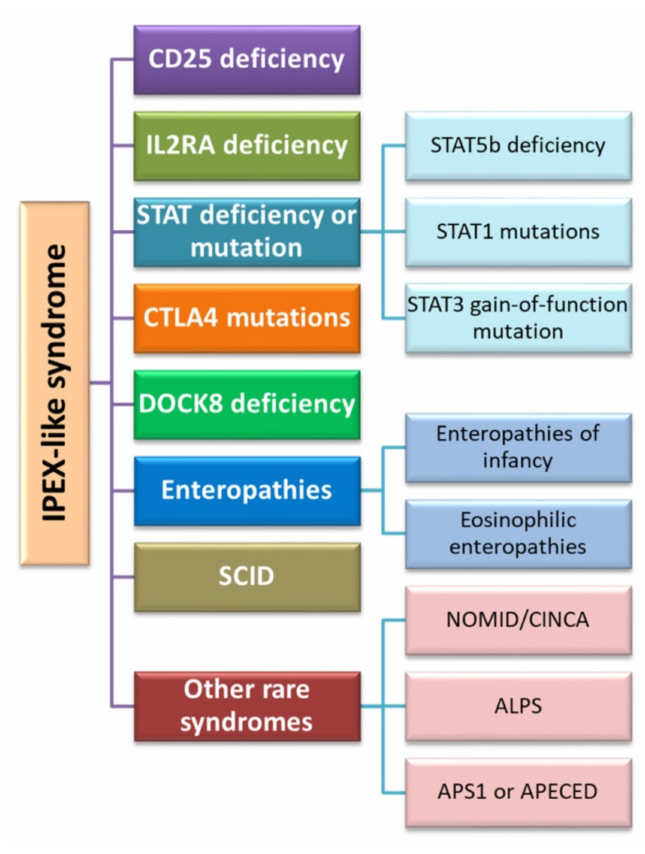
Figure 6. Diseases classified into IPEX-like syndromes (based on